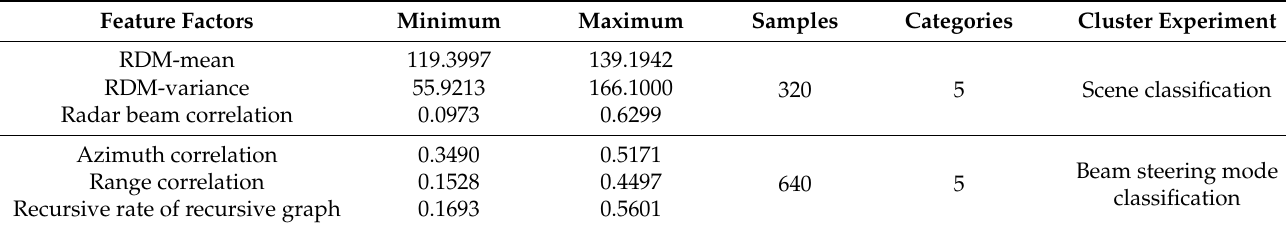
Table 1. Feature factor for clustering process of different scenarios and beam control modes. Feature